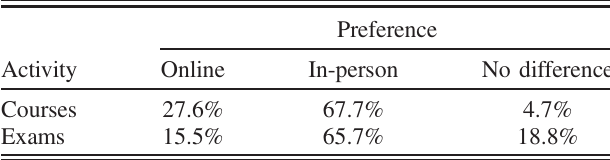
TABLE II. Students ’ preference about attending courses and taking exams online or in